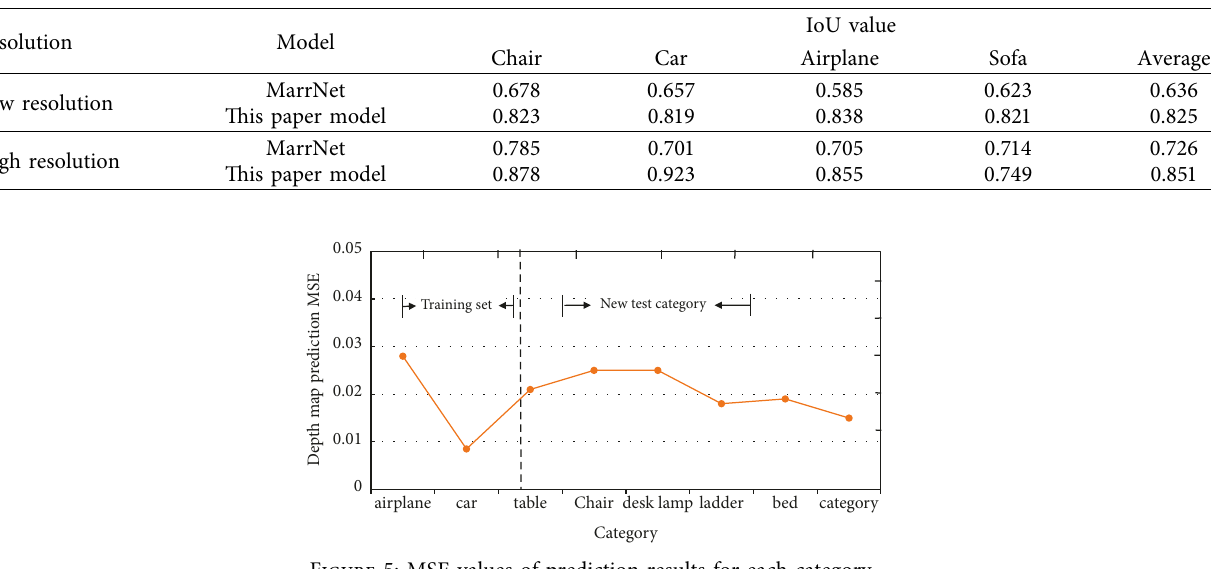
Table 3: Comparison of IoU values of images with different resolutions.